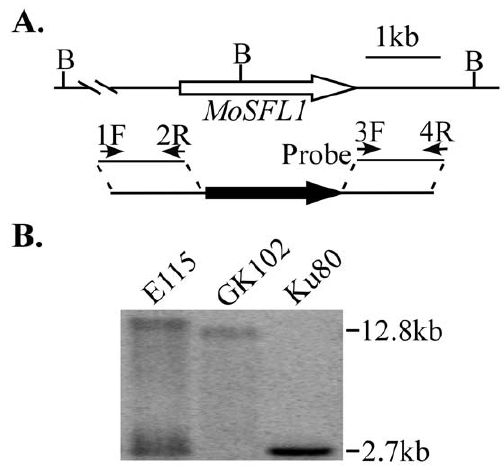
Figure 3. The MoSFL1 gene replacement vector and mutants. A. The MoSFL1 genomic region and gene replacement construct. The upstream and downstream flanking sequences were amplified with primers 1F/2R and 3F/4R, respectively, and connected with the hph cassette by double joint PCR. B, Bam HI. B. Southern blot of Bam HI- digested DNA of Ku80, Mosfl1 mutant GK102, and ectopic transformant E115 was hybridized with the downstream sequence of MoSFL1 amplified with primers 3F and 4R as the probe. Because of the Bam HI site located in the middle of the MoSFL1 gene, the Mosfl1 deletion mutant had a 12.8-kb band instead of the wild-type 2.7-kb band.